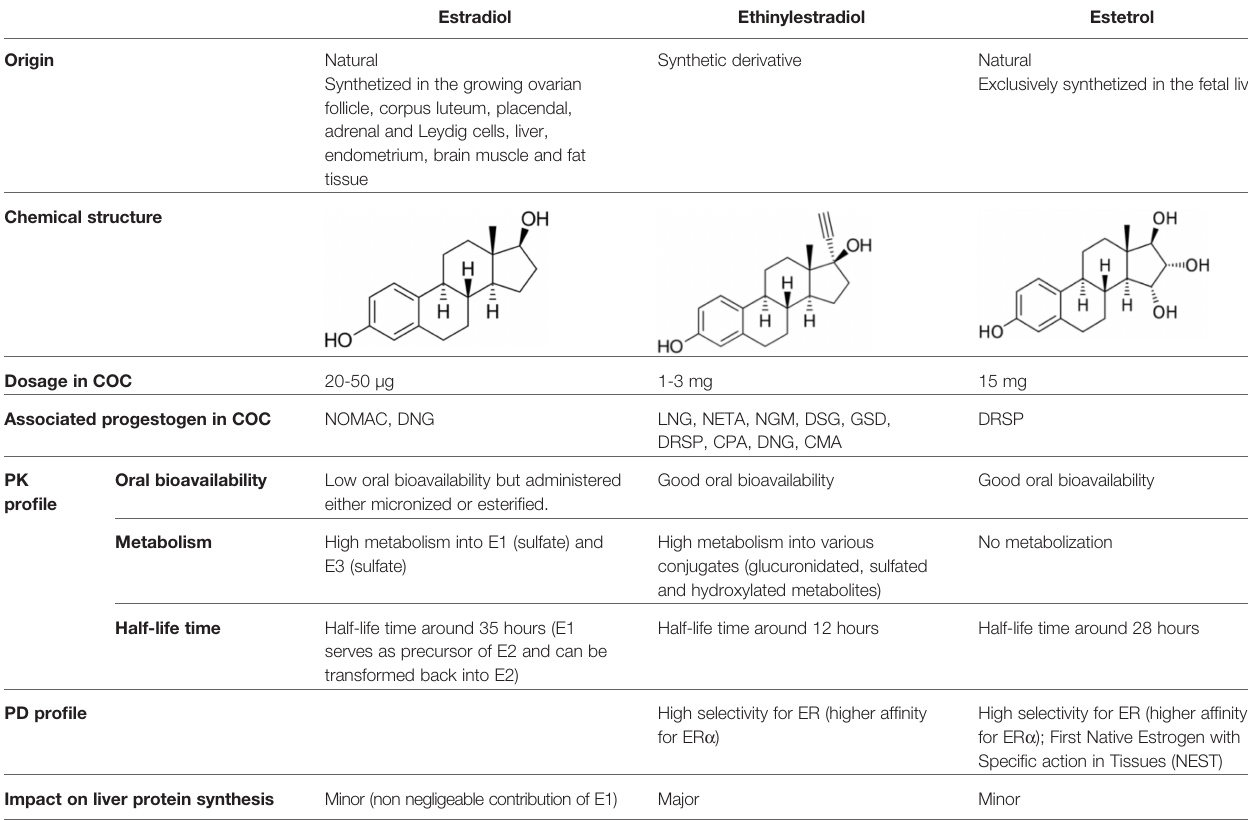
TABLE 4 | Comparison estradiol (E2), ethinylestradiol (EE) and estetrol